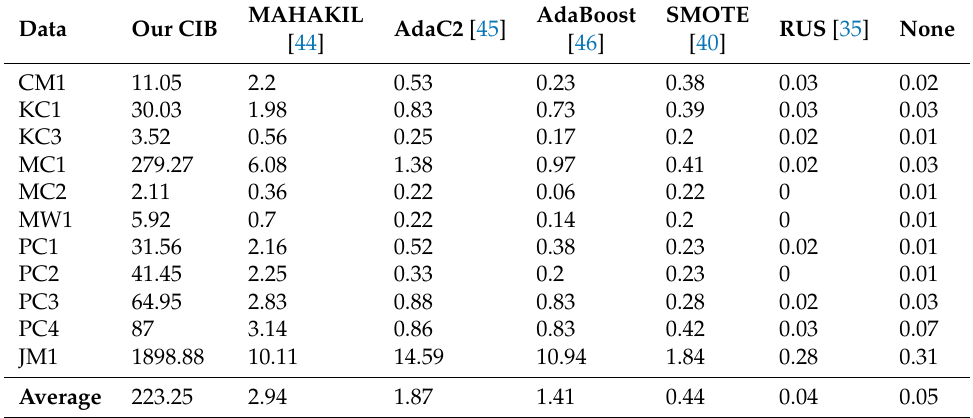
Table 14. Testing time of CIB and the baselines (in second).